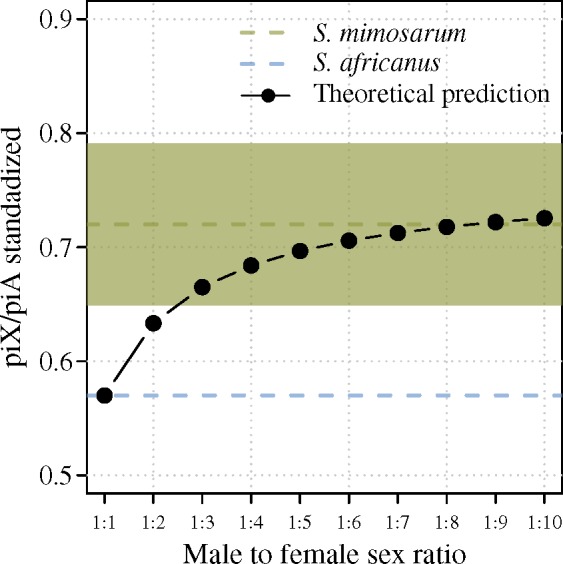
Theoretically expected piX/piA as a function of male to female sex ratio (black dots). The expected piX/piA is standardized according to the finding that Stegodyphus africanus has a lower piX/piA than the expected 0.75, which we infer to be caused by a lower X chromosome mutation rate and the effect of linked selection, and assume to have a similar effect in S. mimosarum. Point estimates of piX/piA for the two species are depicted with dotted lines, and for S. mimosarum, the 95% confidence limits of this estimate are shown.